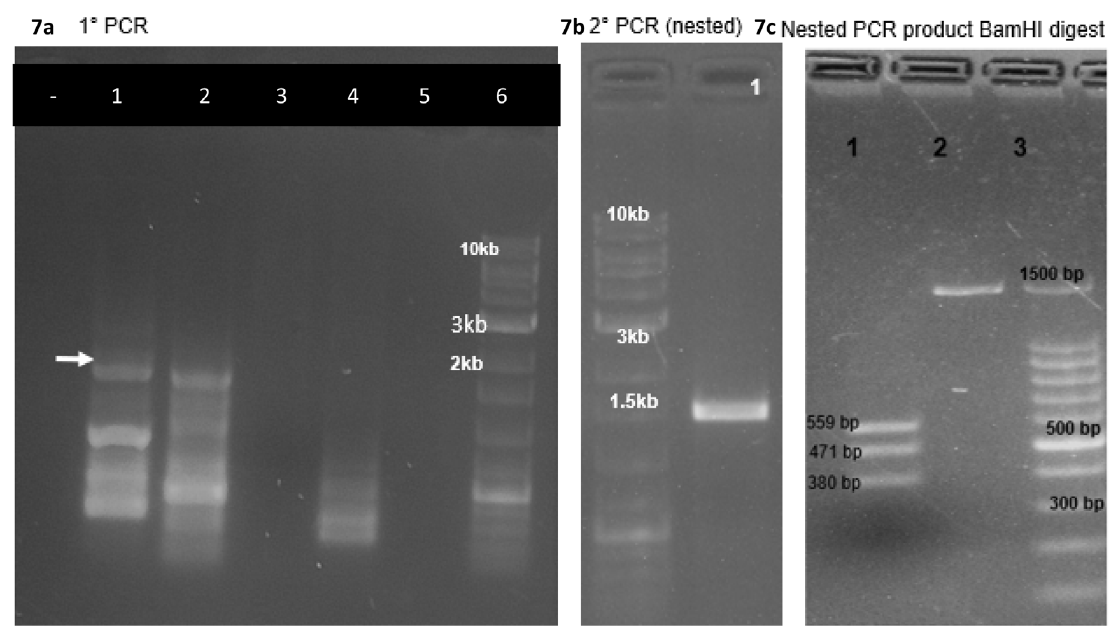
Figure 7. ( a ) The gDNA isolated from transfected cells (Cas9-sgRNA plasmid alone) after 72h, (Cas9-sgRNA plasmid plus donor vector) after 21 days of puromycin selection were used as PCR templates (lane 1, 2) with a forward primer complementary to a region upstream of the 5’ recombination overhang of the vector and a reverse primer complementary to a sequence in the puromycin resistance gene to amplify a segment spanning from a site in the host cell genomic DNA slightly upstream of the genomic integration site to a segment donated by the donor vector (puromycin resistance gene). Note that genomic DNA from untreated HEK293T cells did not give any products in the expected range (lane 3, 4). ( b ) The PCR product mentioned in (a) was used as a template for a nested PCR. ( c ) The PCR product mentioned in ( b ) was confirmed by restriction enzyme digestion (BamH1) and sequencing (Primers: Extended data, Supp.Table 4) 10